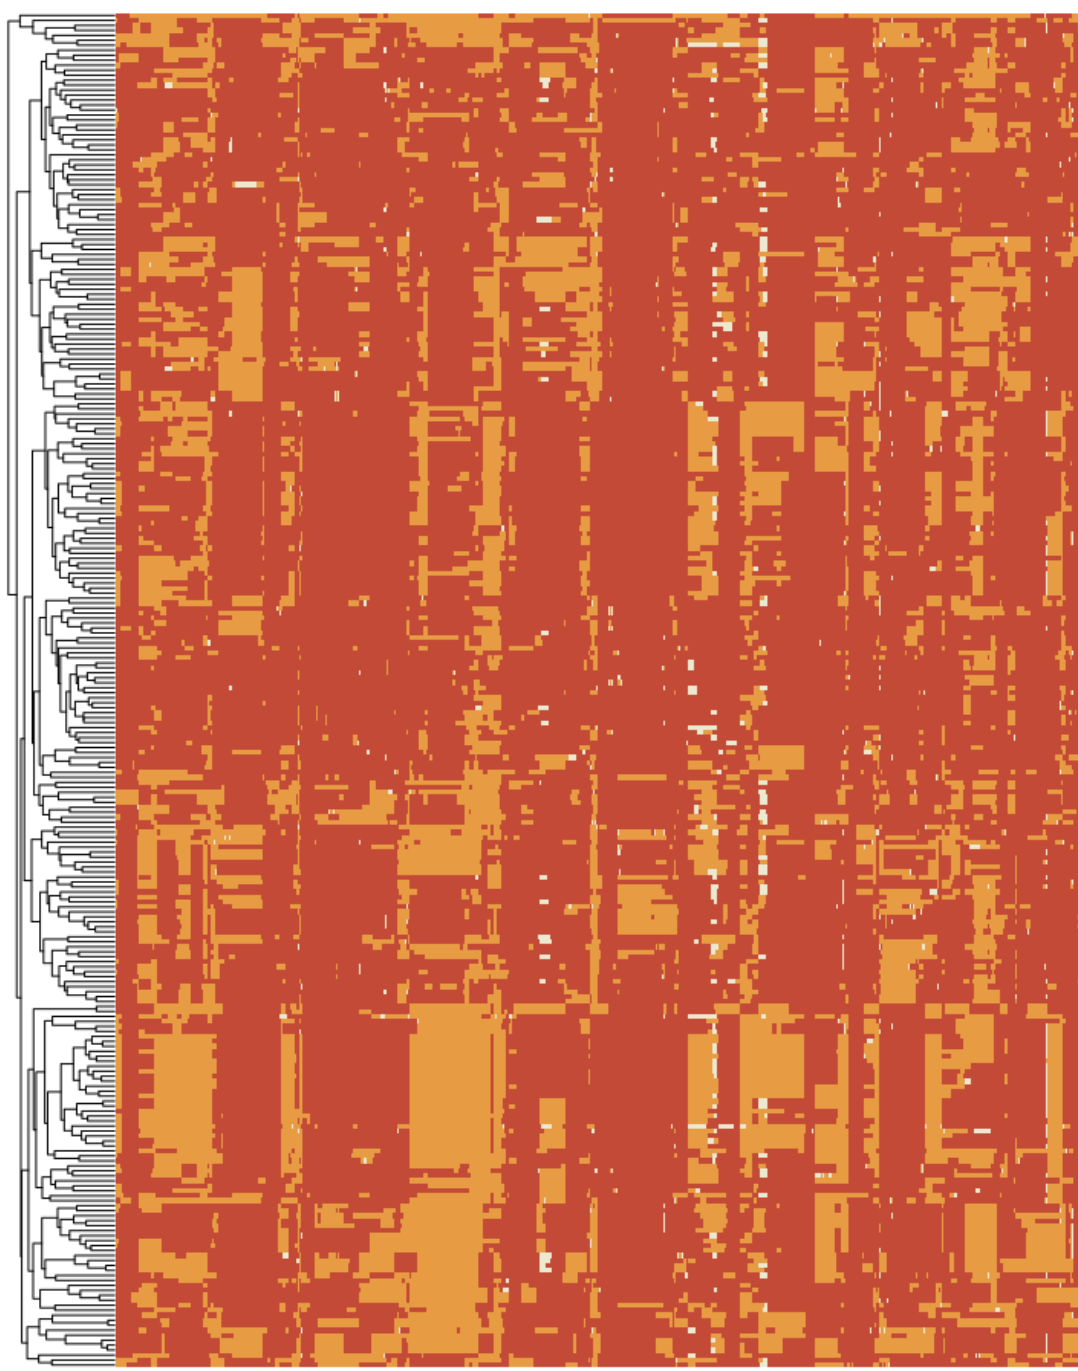
Figure 4. Similarity clustering of 272 RILs population based on 4758 bin markers. Red indicates the male parent, yellow indicates the female parent and white indicates the recombination/NA region.